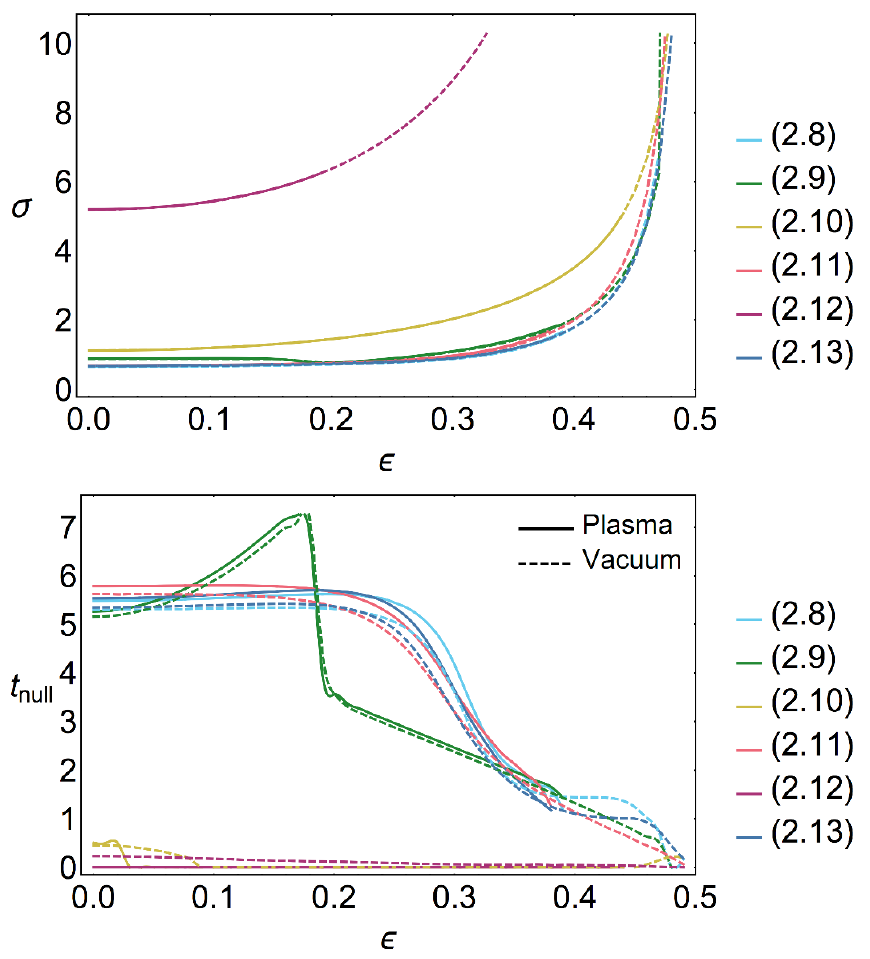
Figure 7 . We compare the downward angles of the string endpoints after nulli(cid:12)cation (cid:27) de(cid:12)ned as described in the text (top panel) and the nulli(cid:12)cation times (bottom panel) for strings that are produced and then nullify in plasma (solid curves) to those that are produced and then nullify in vacuum (dashed curves) as in the previous subsection. All strings were produced at z 0 = 0 : 04 except for those with initial conditions (2.12), which were produced at z 0 = 0 : 005. nulli(cid:12)cation time t as the time after which this initial downward angle changes by null